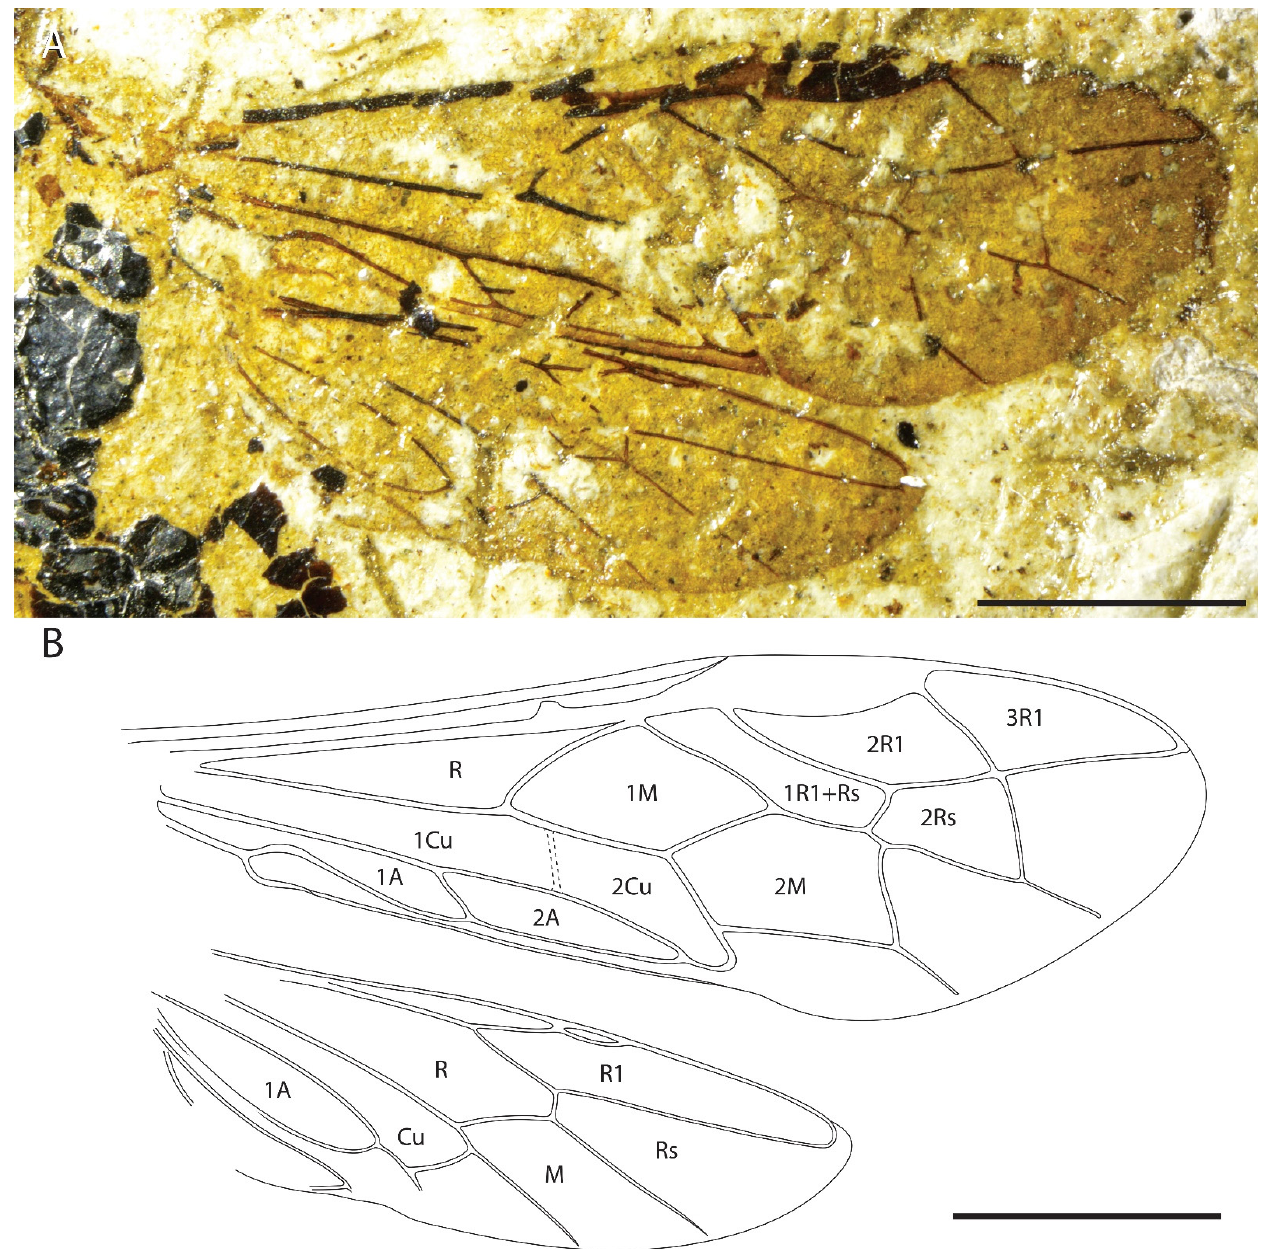
Figure 3. Emphytus miocenicus sp. nov., holotype IGR-PAL-2859. Right fore and hind wings. ( A ) Pho- tograph. ( B ) Reconstructions with wing venation and cell names labeled. Scale bars = 2